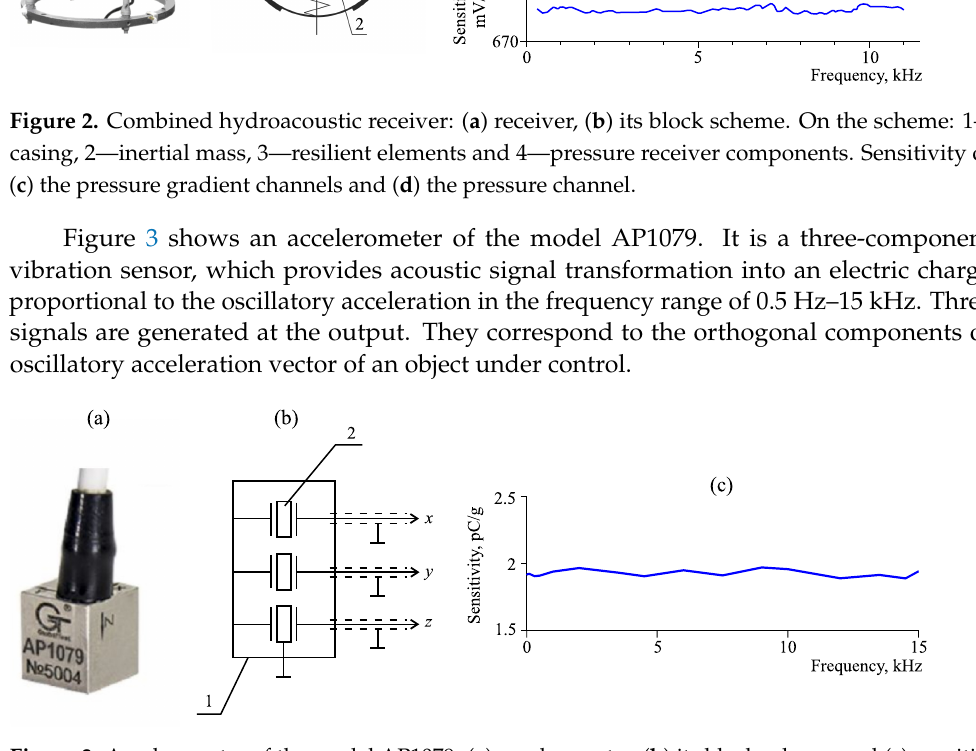
Figure 3. Accelerometer of the model AP1079: ( a ) accelerometer, ( b ) its block scheme and ( c ) sensitiv- ity of channels . On the scheme: 1—casing; 2—inertial mass.